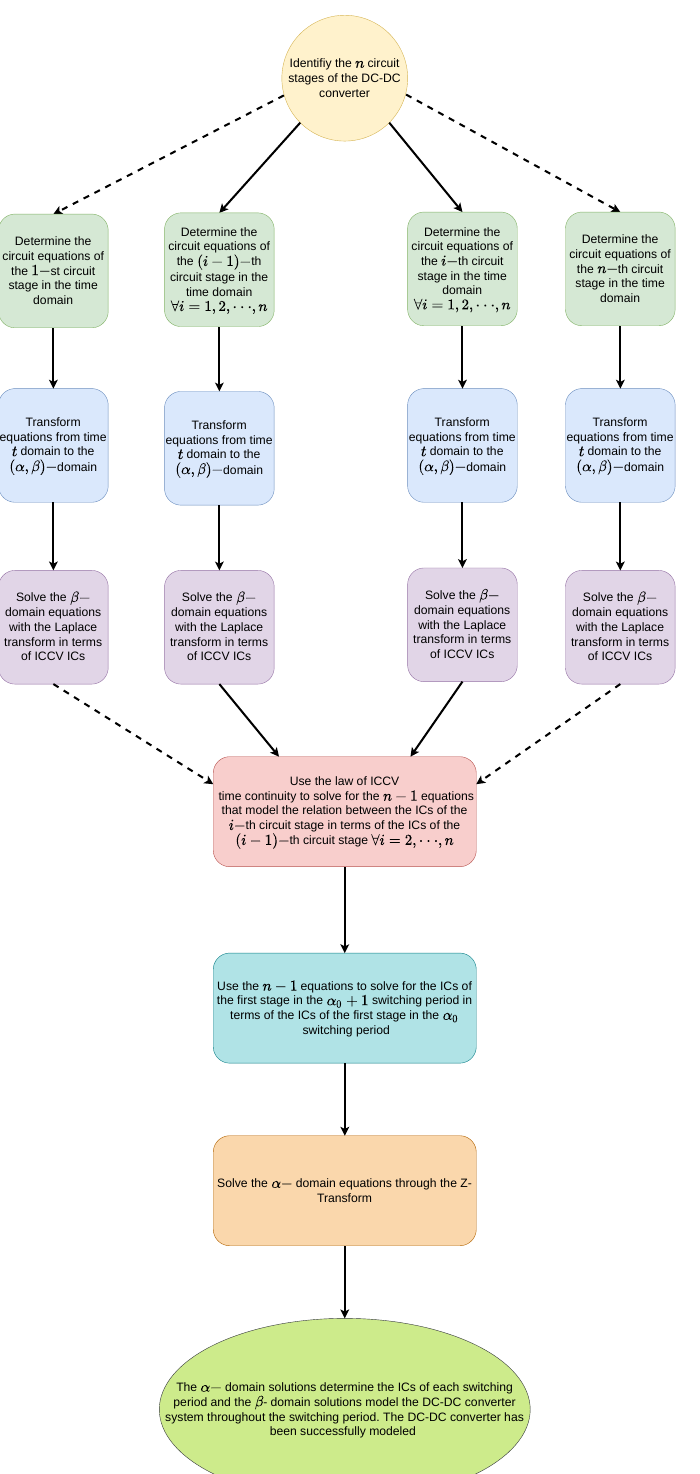
Figure 2. Brief summary of the proposed modeling method for DC-DC converter